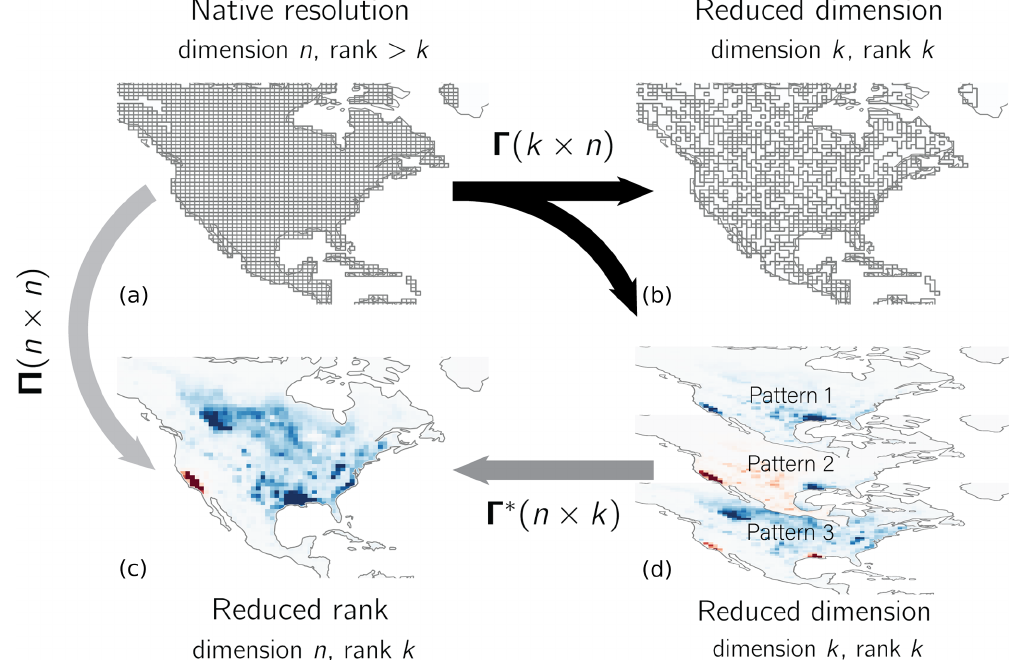
Figure 1. Dimension and rank reductions of a gridded emissions field. The linear transformation matrix (cid:48) reduces the dimension of the original state space (a) , either discretely by aggregating grid cells to generate a multiscale grid (b) or non-discretely by projecting along the patterns given by the rows of (cid:48) ( c , with positive values in red and negative in blue). The reverse transformation (cid:48) ∗ restores the dimension but not the rank, producing a low-rank subspace of the original state space (d) . The projection (cid:53) = (cid:48) ∗ (cid:48) reduces the rank but not the